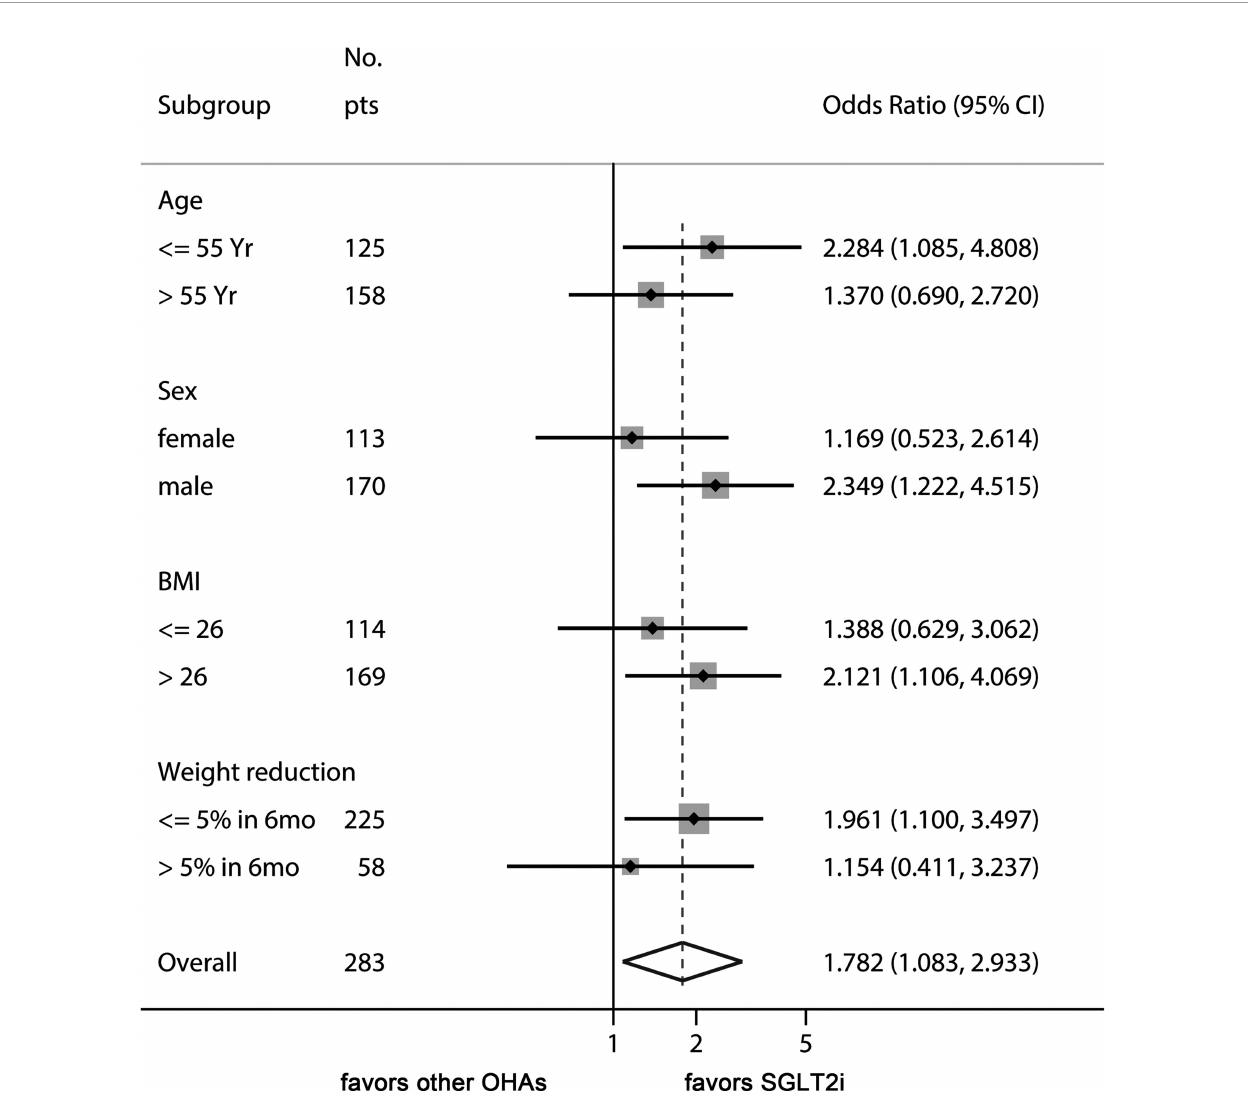
FIGURE 2 | Sensitivity analysis of odds ratio of SGLT2is for managing ALT levels. This Forest plot indicates the odds ratio of SGLT2i over control for the endpoint of ALT decrease ≥ 15% of baseline values. The bene fi t of SGLT2i for ALT decrease was more prominent in younger patients, male sex, high baseline BMI, and patients with less weight